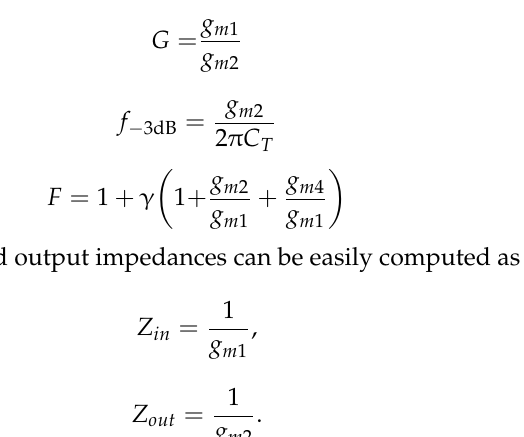
Figure 1. CMOS LNA based on current conveyors with ideal current sources. The DC gain ( G ), bandwidth ( f − 3dB ), and noise factor ( F ) can be calculated as shown by (1), (2), and (3), respectively, where g m 1 and g m 2 are the M1 and M2 transconductances, C T represents the total parasitic capacitance at the output node, and γ is the excess noise factor, which is a constant that depends on the transistor